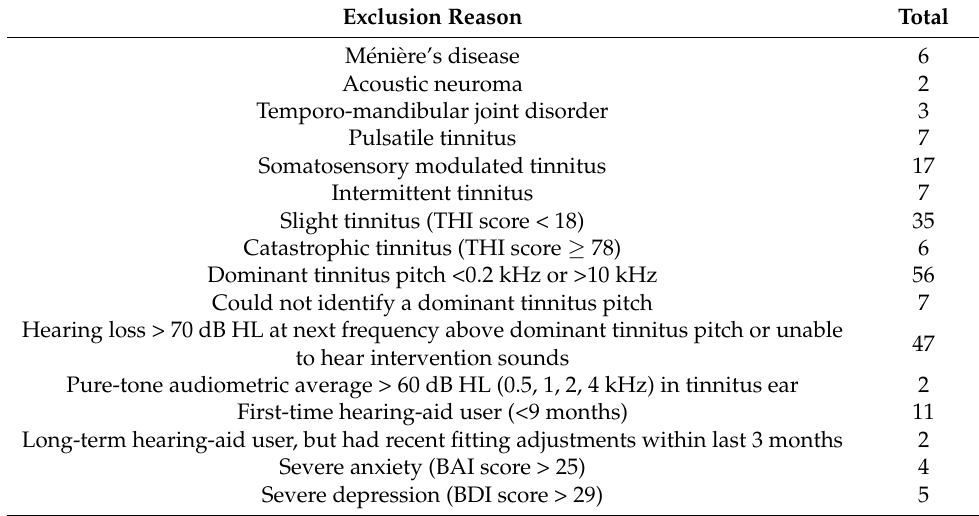
Table 2. Breakdown of the reasons for excluding 217 participants (specific criteria listed in the